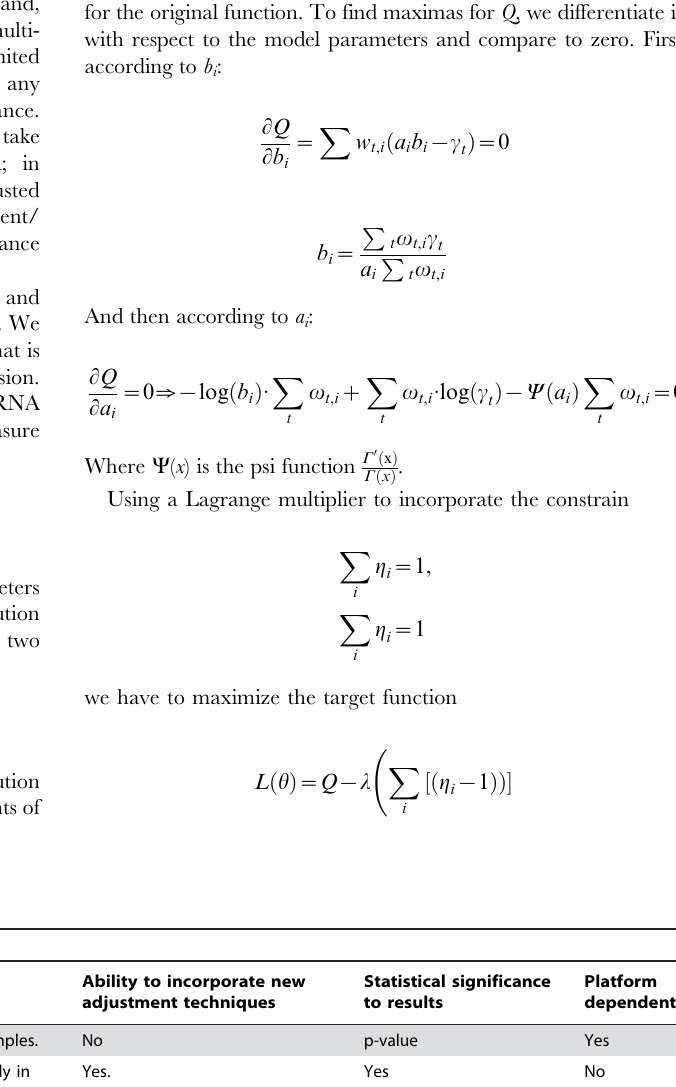
Statistical significance to results